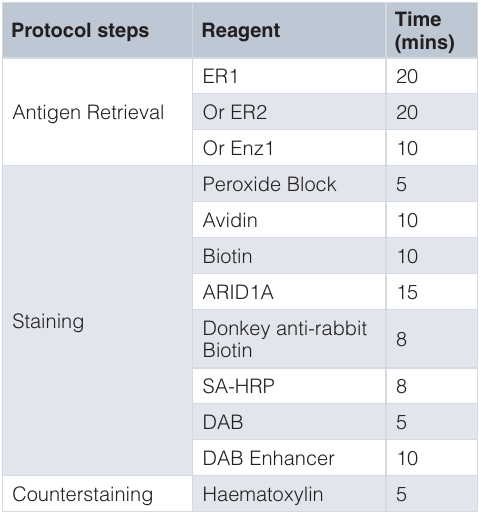
Table 4. Staining protocol for ARID1A